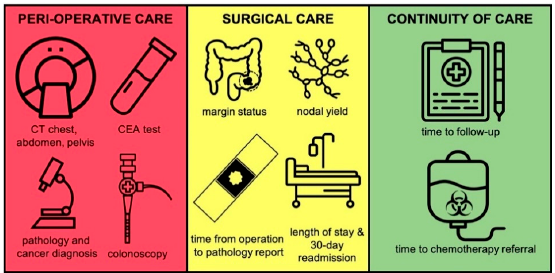
Figure 2. The three moments of cancer